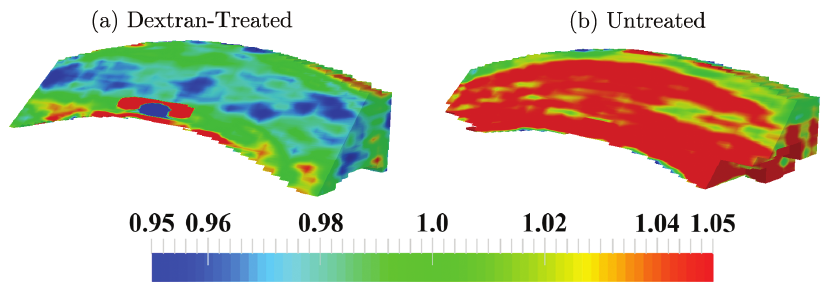
Fig. 7. (Color online) Maps of the volume ratio obtained in (a) dextran-treated, and (b) untreated globes after in°ation from 10 mmHg to 12 mmHg.